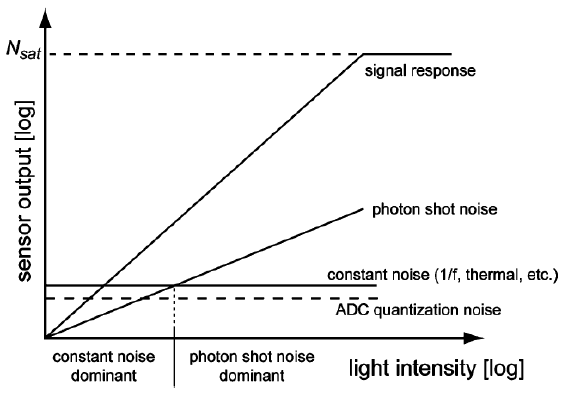
Figure 3. Pixel response to light intensity and main noise sources